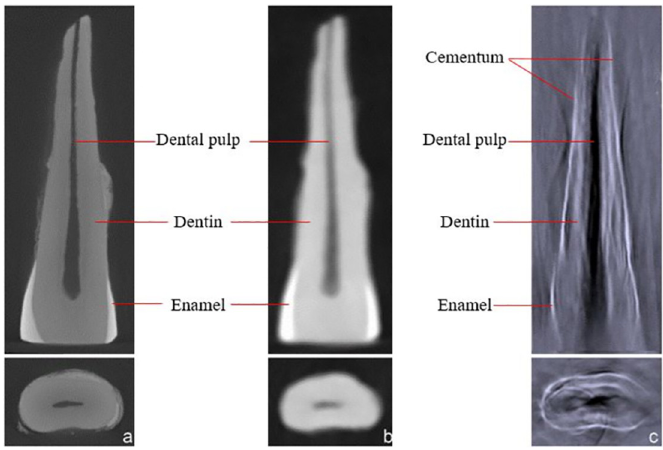
Fig 6. Comparison of μ -CT, CBCT, and PAT images. The images show the longitudinal and transverse section of a human mandibular incisor. (a) μ -CT image, (b) CBCT image, (c) PAT image (680 nm).